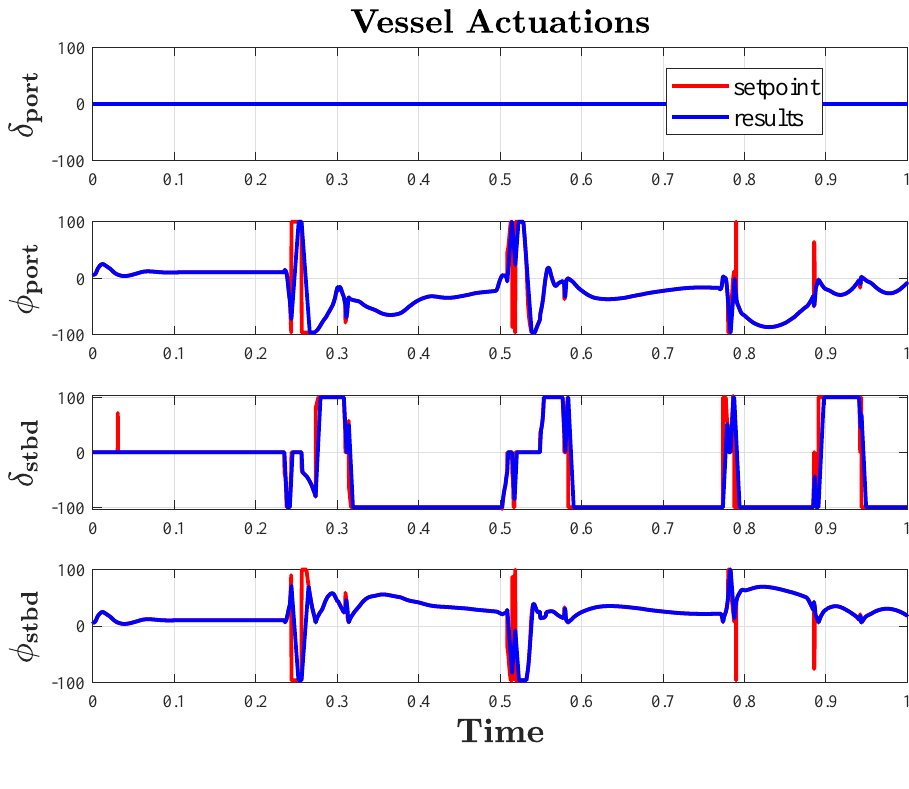
Figure 11. Vessel